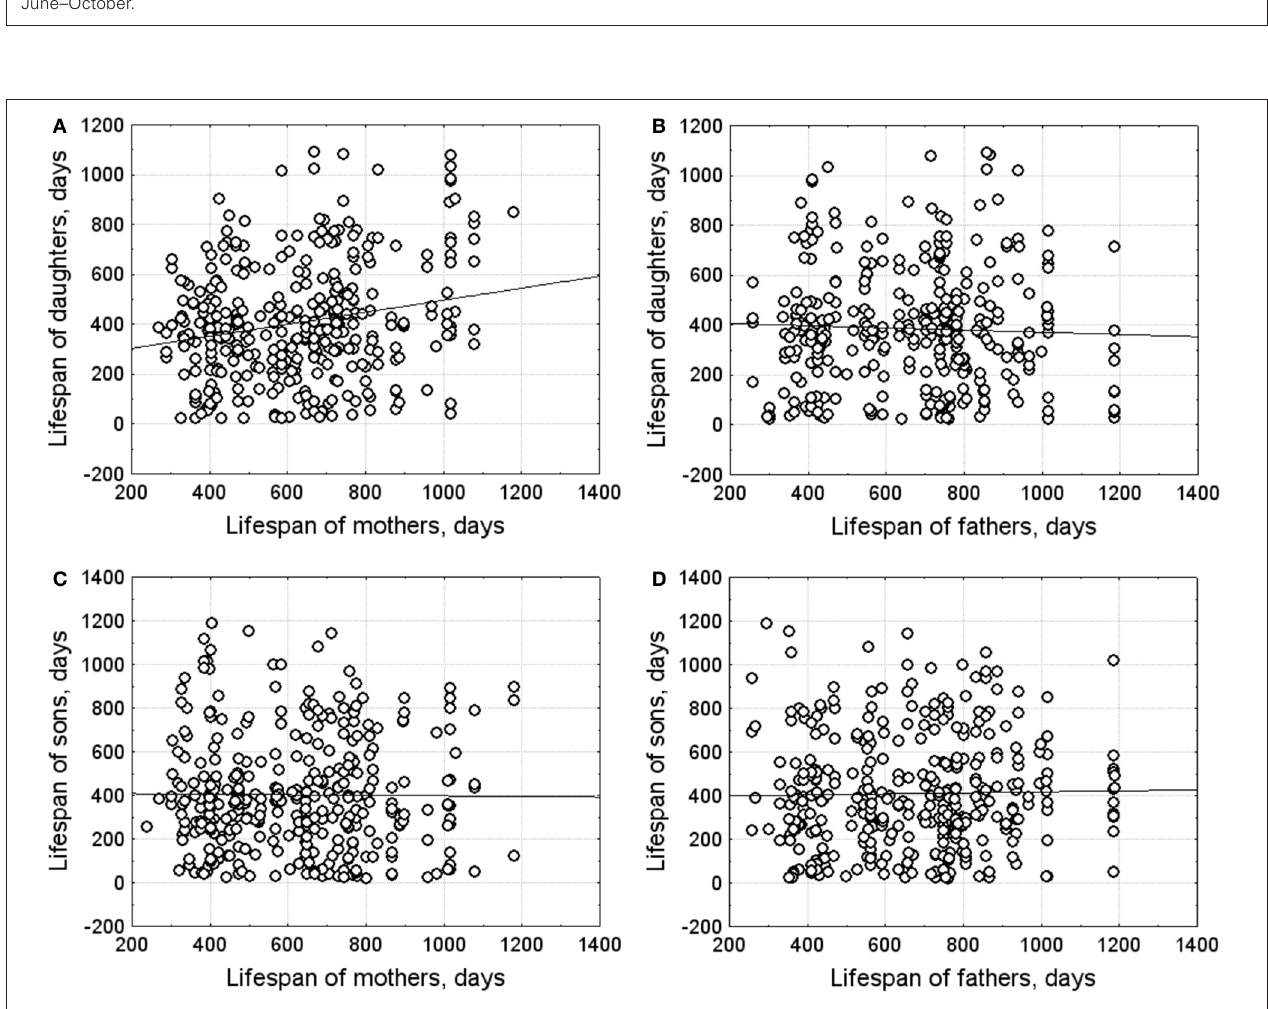
FIGURE 3 | Survival curves for spring- and summer-/autumn-born males (left) and females (right). Blue line: born March–May, red line: born June–October.